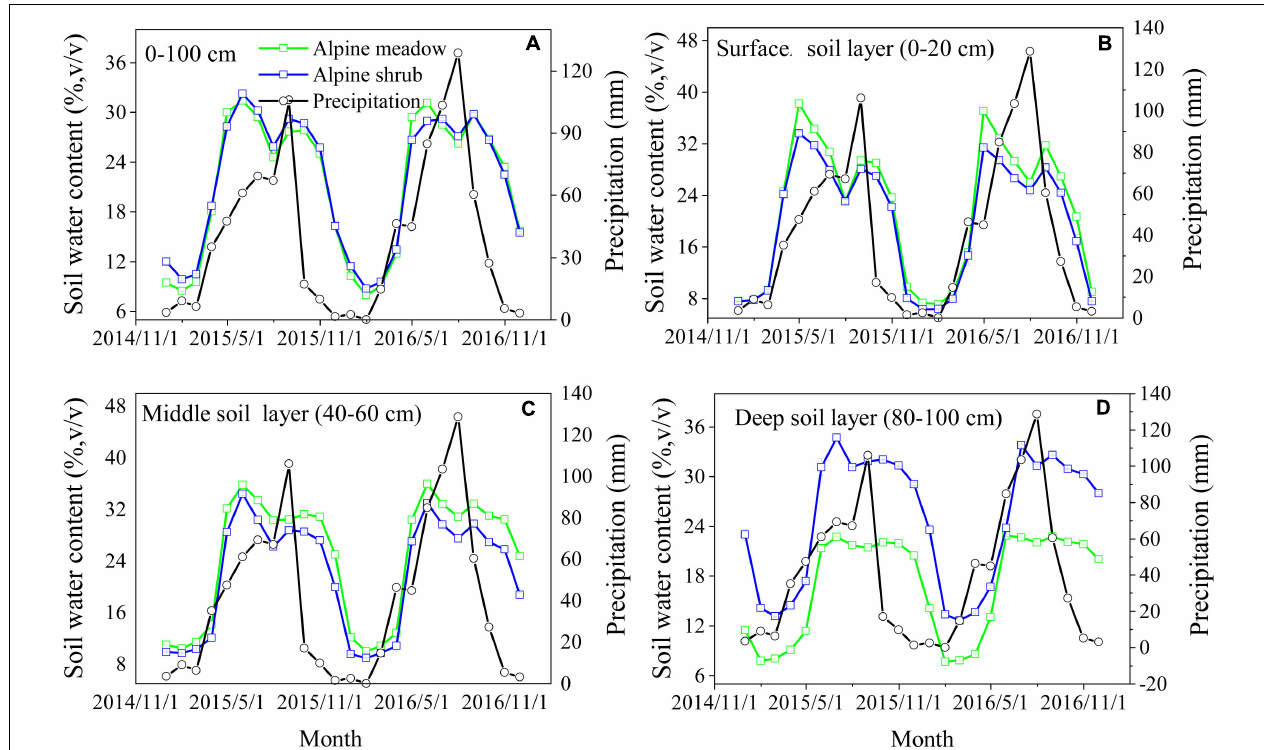
FIGURE 4 | Monthly variations of soil water content for 0–100 cm (A) , surface soil layer (B) , middle soil layer (C) , and deep soil layer (D) across two vegetation types.